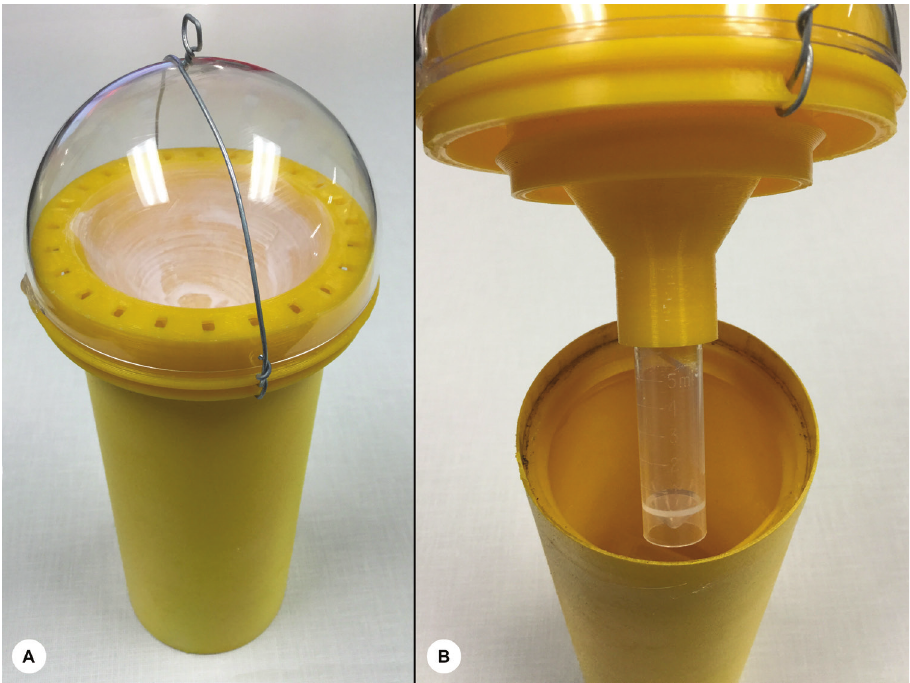
Figure 1. Yellow cylinder trap employed by CAPS Program in Florida A exterior view of trap; the inside of the funnel is coated with Insect-a-Slip B interior of trap where insects are preserved in a vial containing propylene glycol and